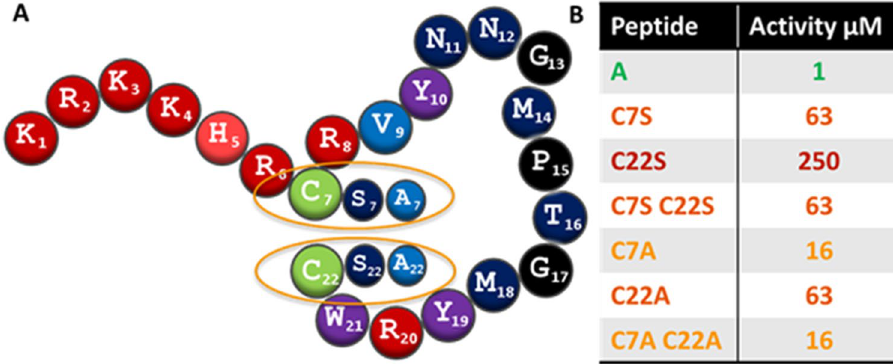
Figure 2. ( A ) Cys7 and Cys22 were substituted individually and in tandem with serine and alanine to give bactofencin variants C7S, C22S, C7S-C22S, C7A, C22A, C7A-C22A. Activity ( µ M) of bactofencin A compared